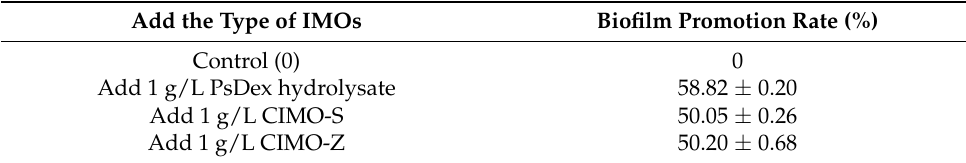
Table 3. Promoting effect of IMOs on formation of probiotic